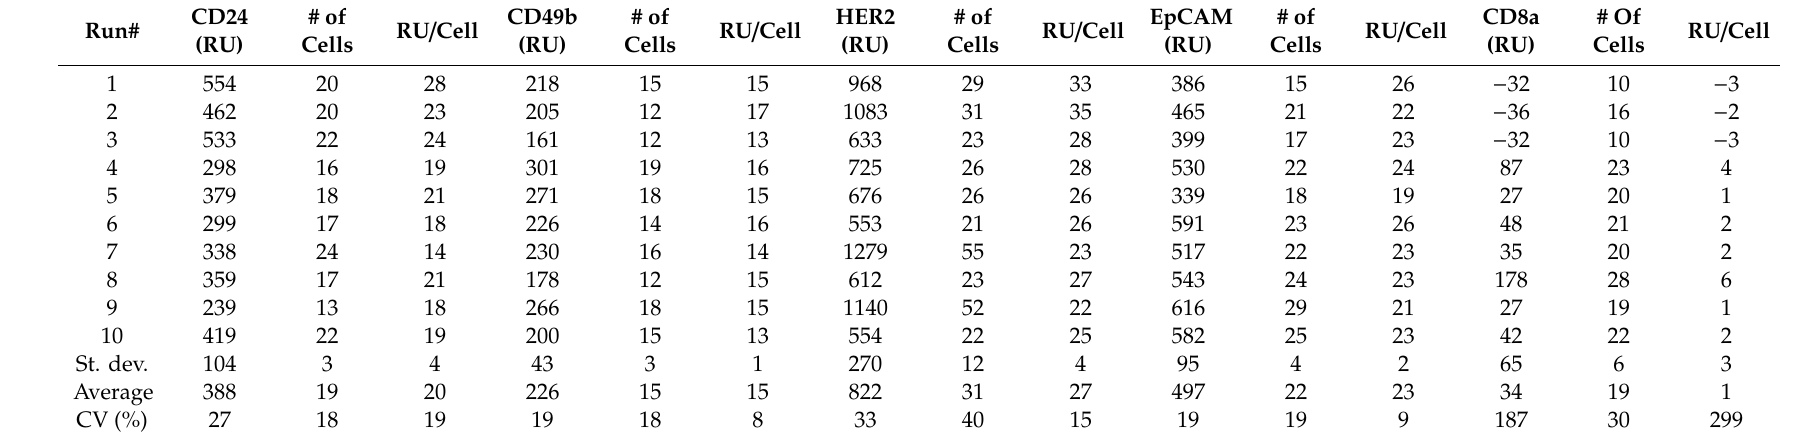
Table 1. Responses of the reproducibility test for CD24, CD49b, HER2, EpCAM and